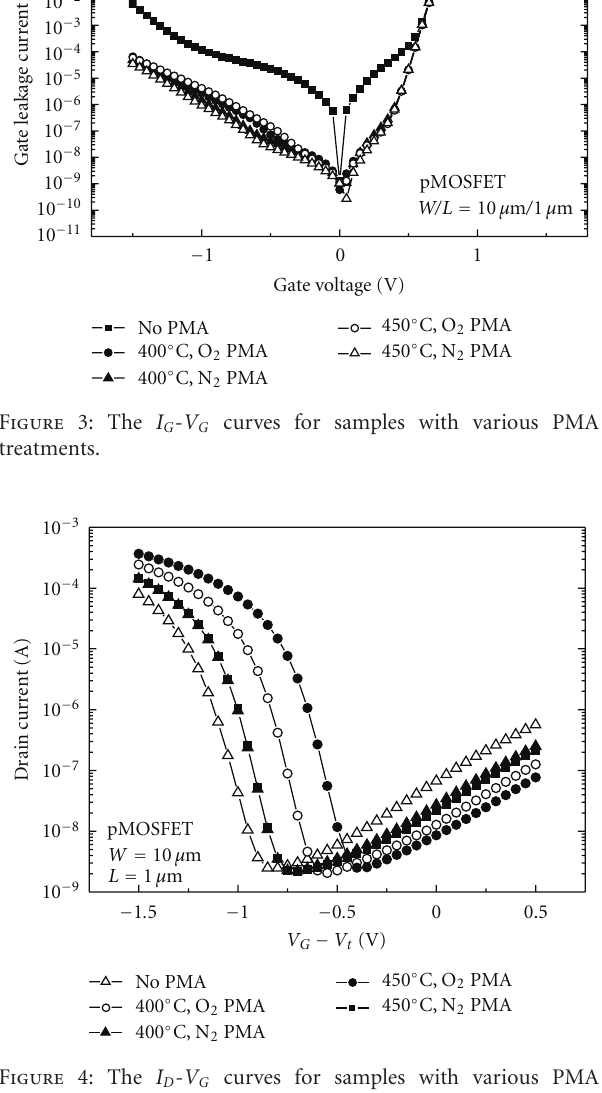
Figure 4: The I D - V G curves for samples with various PMA